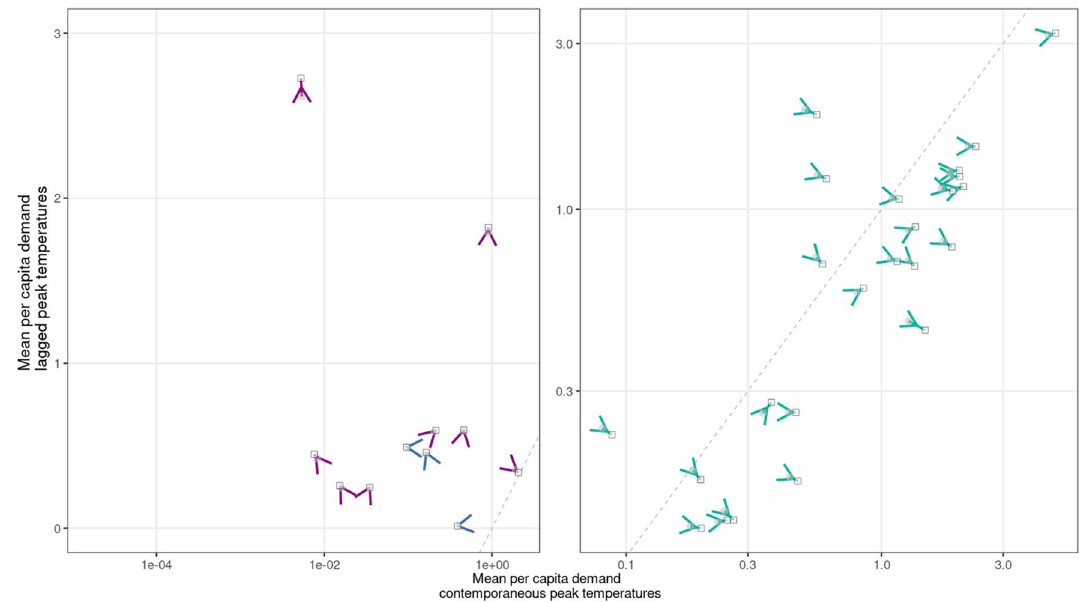
Figure 5. Change in demand components attributable to contemporaneous peak ( > 95th percentile) temperatures (horizontal axis) and the cumulative effects of peak temperature exposures 1–6 h prior (vertical axis). Gray circles indicate mean MWh per capita demand during the historical period, hollow squares indicate median multi-model mean MWh per capita demand in 2050 under RCP 8.5, arrows indicate direction of change.